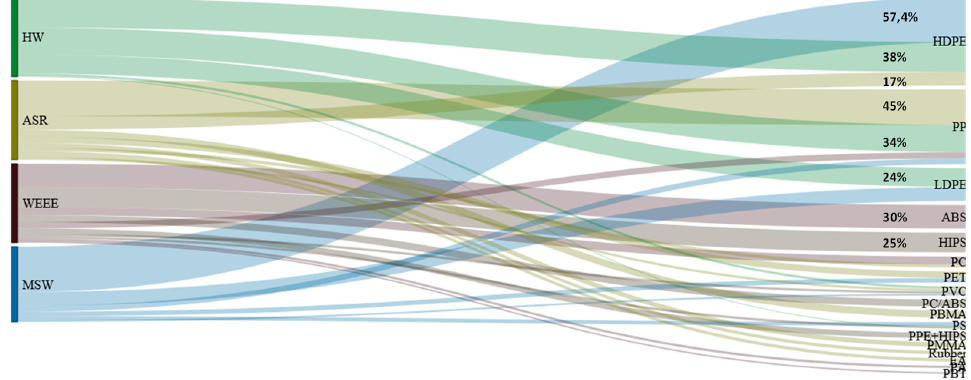
Figure 1. Sankey chart depicting the polymeric composition of different waste streams. Data were gathered from [21–24], and this distribution varies from country to country. HIPS: High impact polystyrene, PC: Polycarbonate, PBMA: Poly butyl methacrylate, EA: Ethyl acrylate, PA: Polyamide, PBT: Butylene terephthalate.